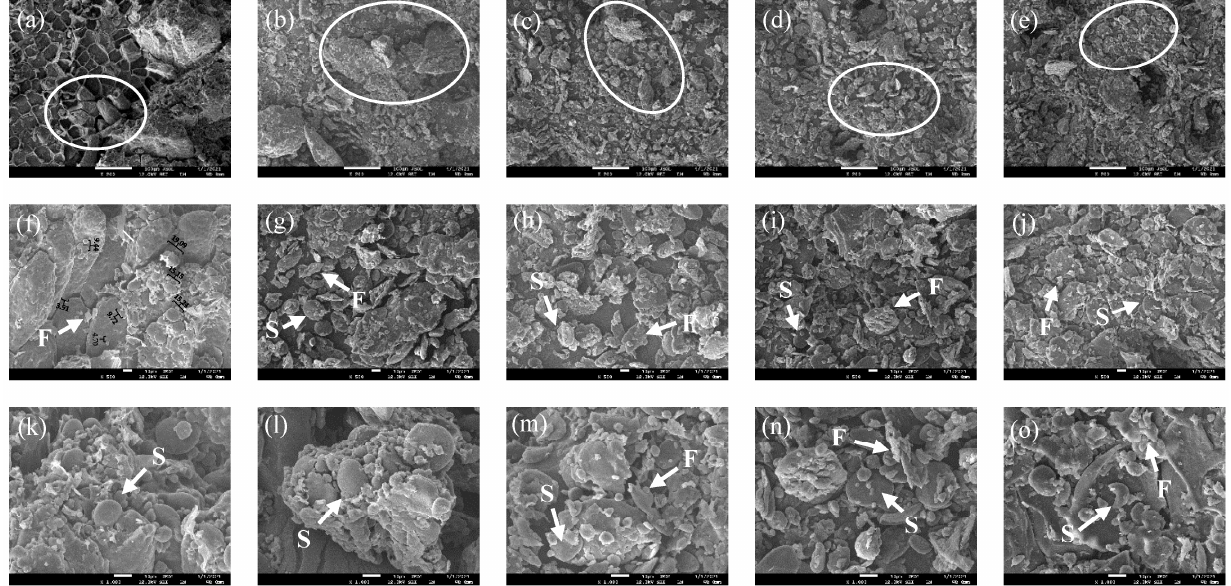
Figure 2. Surface micromorphology of the wheat bran. The magnifications of ( a )–( e ) (B0, B1, B2, B3, and B4) ( f )–( j ) (B0, B1, B2, B3, and B4), and ( k )–( o ) (B0, B1, B2, B3, and B4) are 200×, 500×, and 1000×, respectively. F refers to fiber fragments and S refers to starch granules. The B0, B1, B2, B3, and B4 are the wheat bran prepared under the rolling frequencies 0, 6, 9, 12, and 15 times.